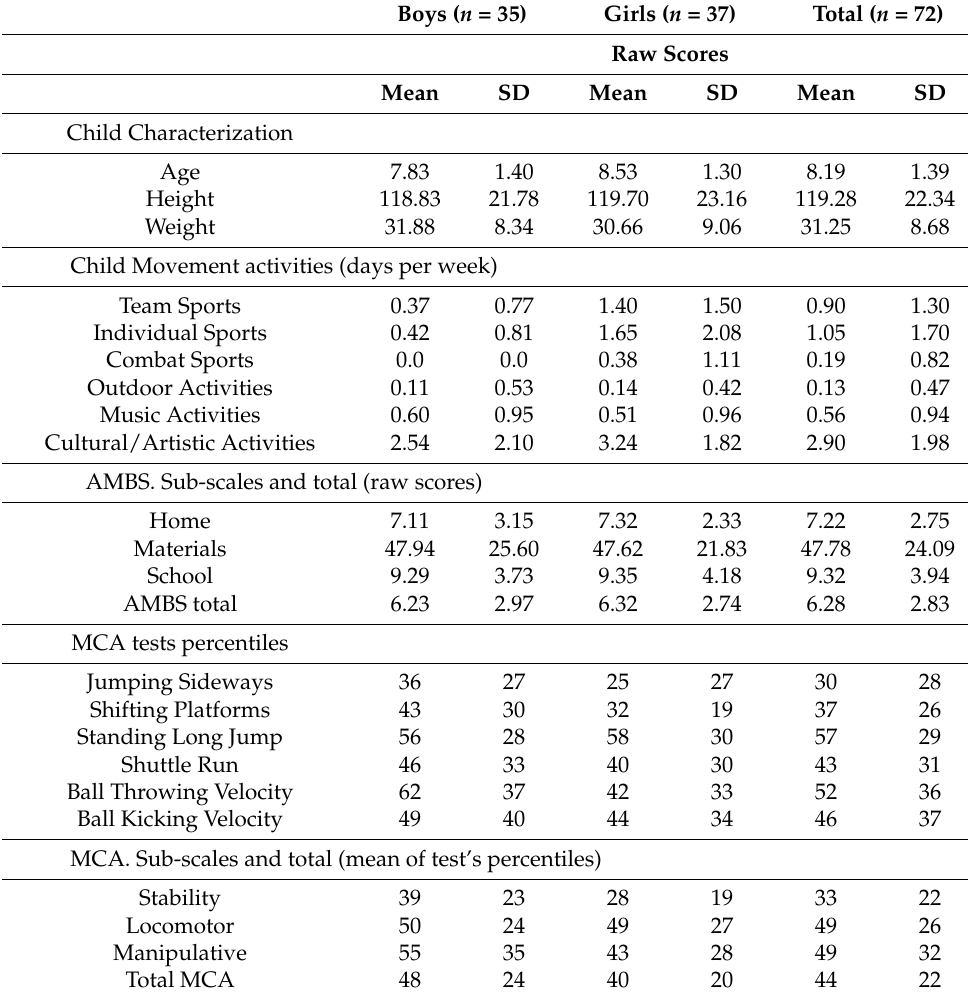
Table 1. Descriptive values of the